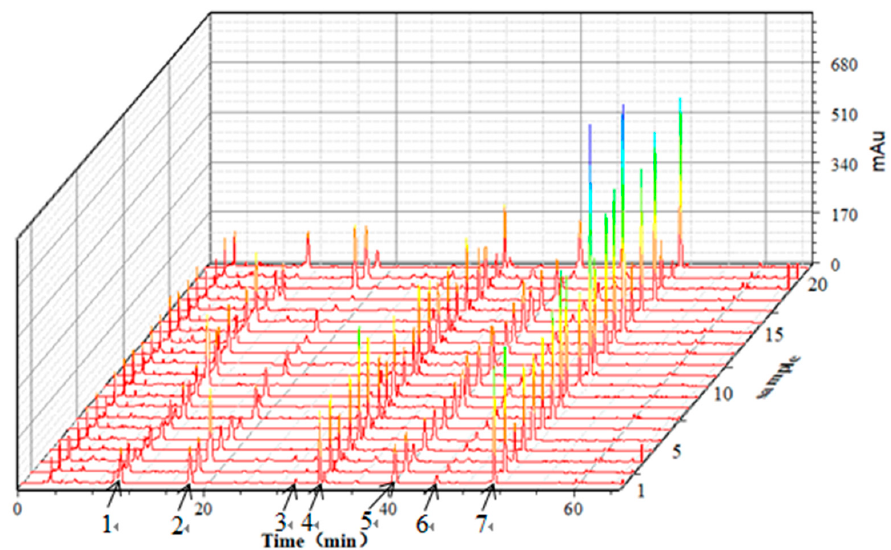
Figure 2. HPLC fingerprints of the 21 batches of G. elata tuber samples. 1—Gastrodin; 2— p -Hydroxy benzyl alcohol; 3—Parishin E; 4— p -Hydroxy benzaldehyde; 5—Parishin B; 6—